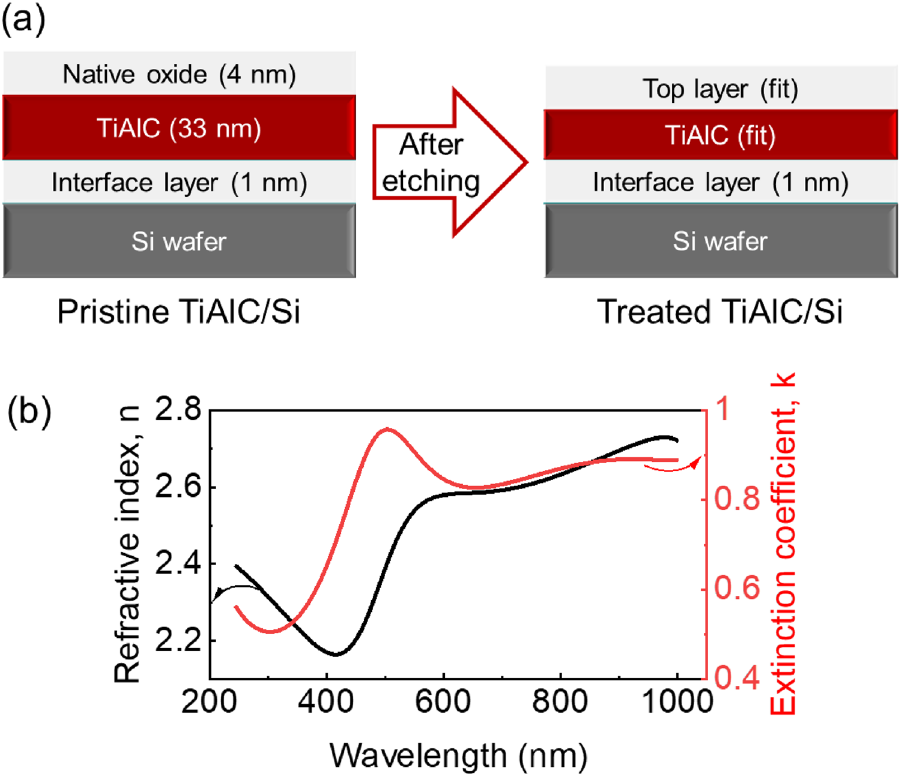
Figure 1. ( a ) A model for spectral fitting of ellipsometric data. A stratified layer model is constructed by a structure of TiAlC sample including top layer (native oxide, deposited layer, or modified layer), TiAlC layer, interface layer, and Si wafer. ( b ) Dispersions of refractive index and extinction coefficient of TiAlC film as functions of wavelength obtained by the Gen-Osc model with fitted parameters as listed in Table 1.